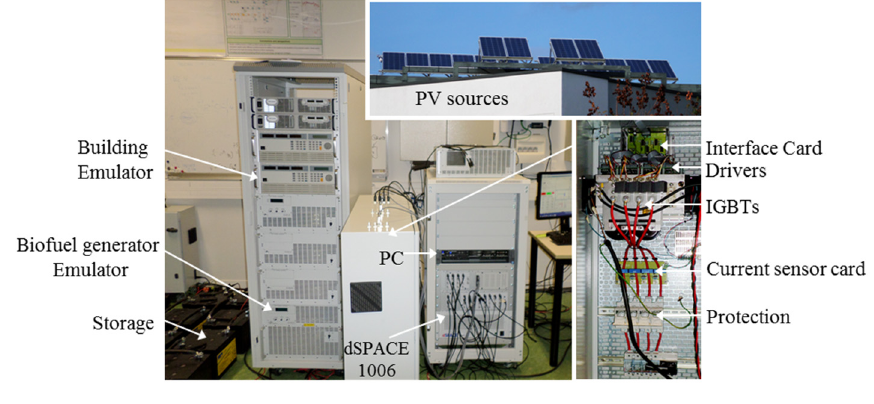
Figure 5. Test bench image.